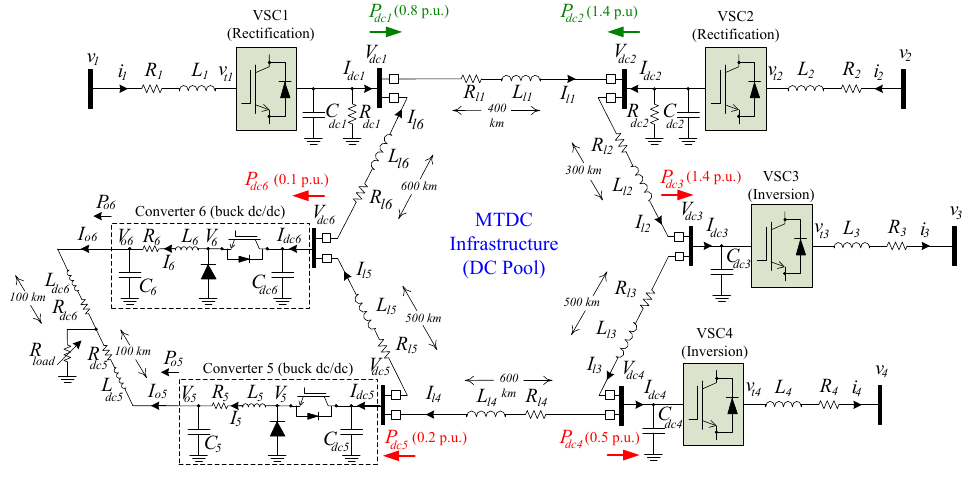
Figure 1. The MTDC system under study.